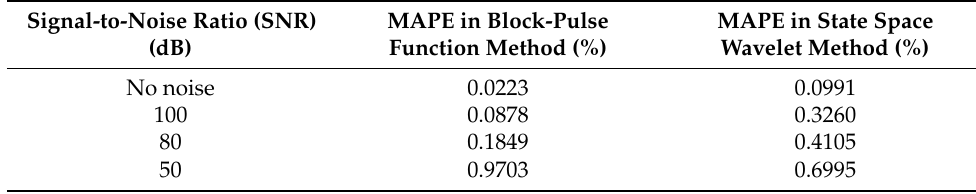
Table 3. Stiffness identification MAPE in two methods at different SNRs.